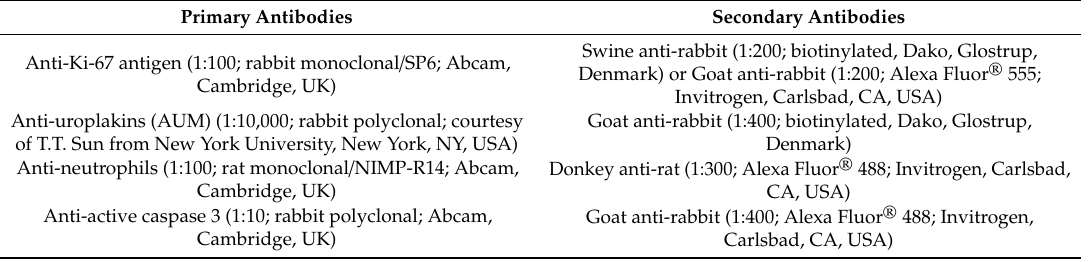
Table 2. Primary and secondary antibodies used for immunohistochemistry on para ffi n sections. Primary Antibodies Secondary Antibodies Swine anti-rabbit (1:200; biotinylated, Dako, Glostrup, Anti-Ki-67 antigen (1:100; rabbit monoclonal / SP6; Abcam, Denmark) or Goat anti-rabbit (1:200; Alexa Fluor ® 555; Cambridge, UK) Invitrogen, Carlsbad, CA, USA) Anti-uroplakins (AUM) (1:10,000; rabbit polyclonal; courtesy Goat anti-rabbit (1:400; biotinylated, Dako, Glostrup, of T.T. Sun from New York University, New York, NY, USA) Denmark) Anti-neutrophils (1:100; rat monoclonal / NIMP-R14; Abcam, Donkey anti-rat (1:300; Alexa Fluor ® 488; Invitrogen, Carlsbad, Cambridge, UK) CA, USA) Anti-active caspase 3 (1:10; rabbit polyclonal; Abcam, Goat anti-rabbit (1:400; Alexa Fluor ® 488; Invitrogen, Cambridge, UK) Carlsbad, CA,